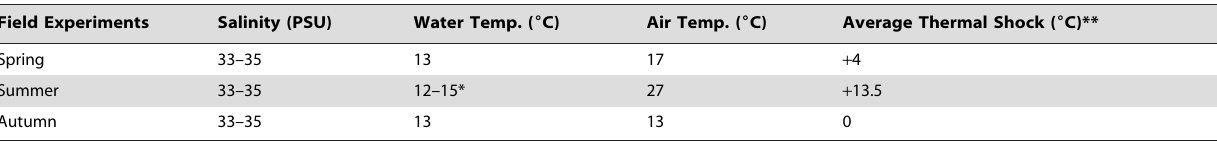
Table 2. Environmental parameters recorded during recovery in the field